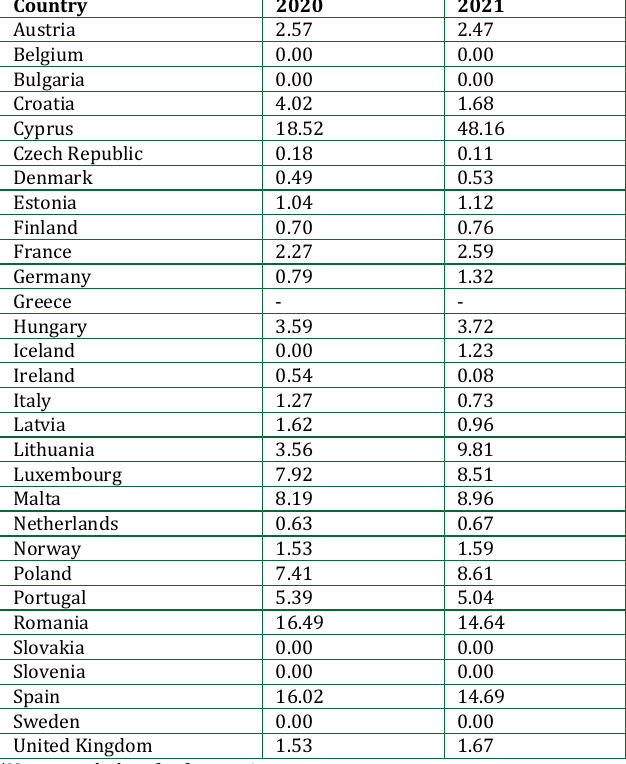
Table 7: Forecasted AMR’s percentage for Streptococcus pneumoniae